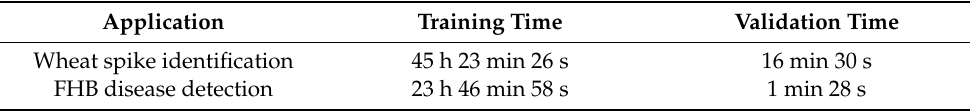
Table 2. The total time for model training and